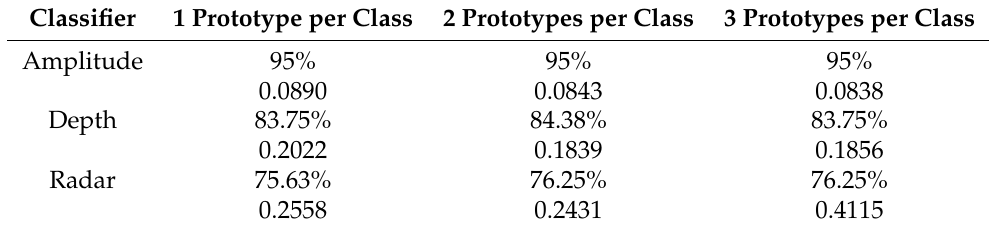
Table 1. Single-input classifiers training using each of the three data sets corresponding to sensors inside the ToF/Radar fusion system.